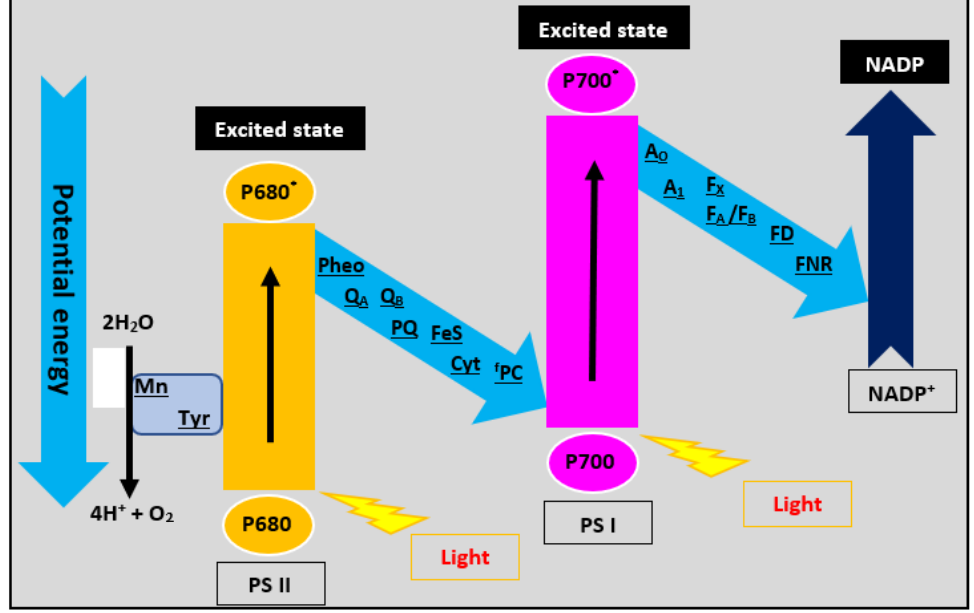
Figure 15. Schematic representation of the charge separation mechanism in natural photosynthesis known as the Z-scheme.